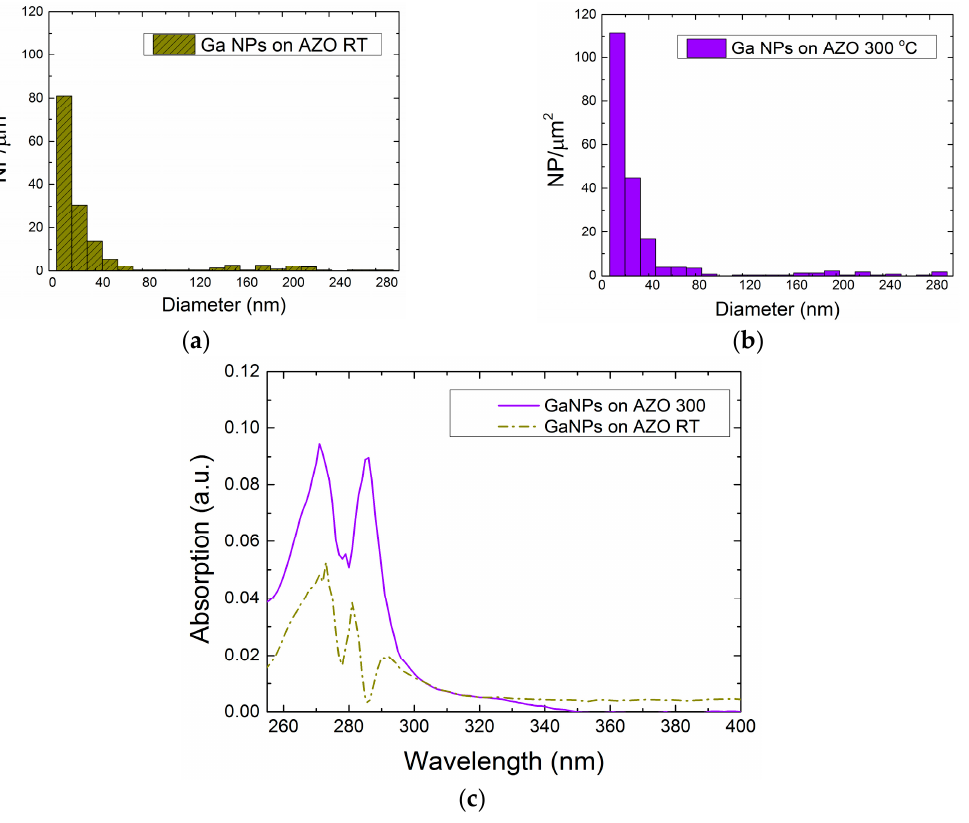
Figure 4. As-evaporated distributions of Ga NPs on ( a ) an AZO layer deposited at RT and ( b ) AZO layer deposited at 300 °C. ( c ) Absorption spectra in THF solvent.